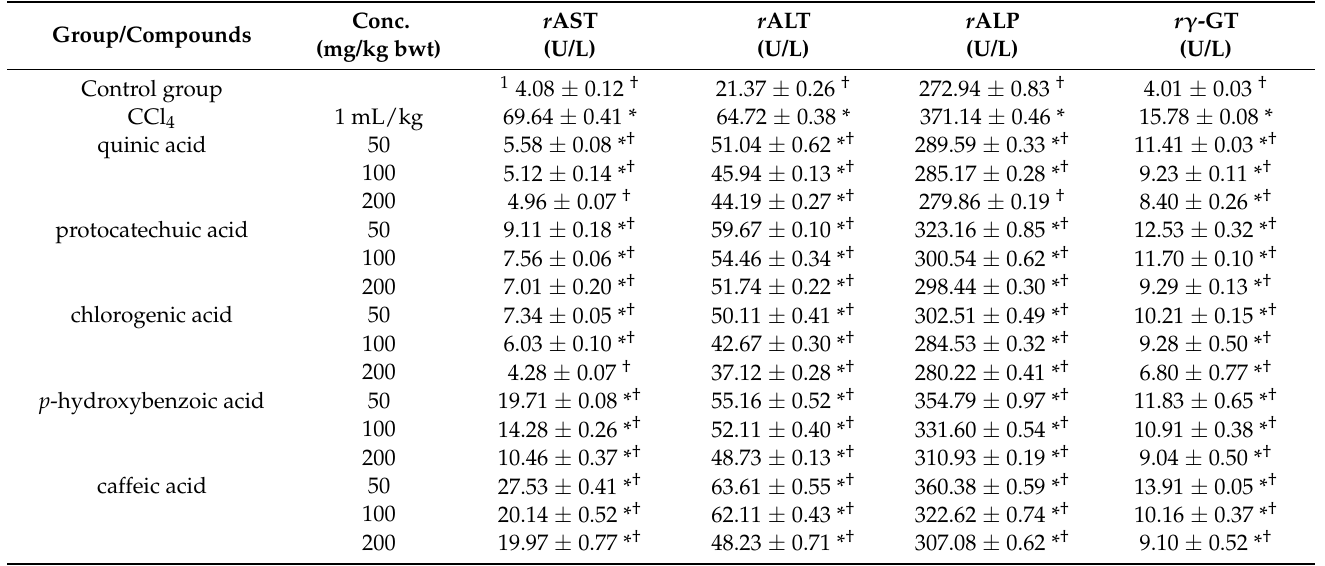
Table 5. Catalytic activities of serum biochemical markers within the rats exposed to different doses of compounds found in N. cataria extracts and CCl 4